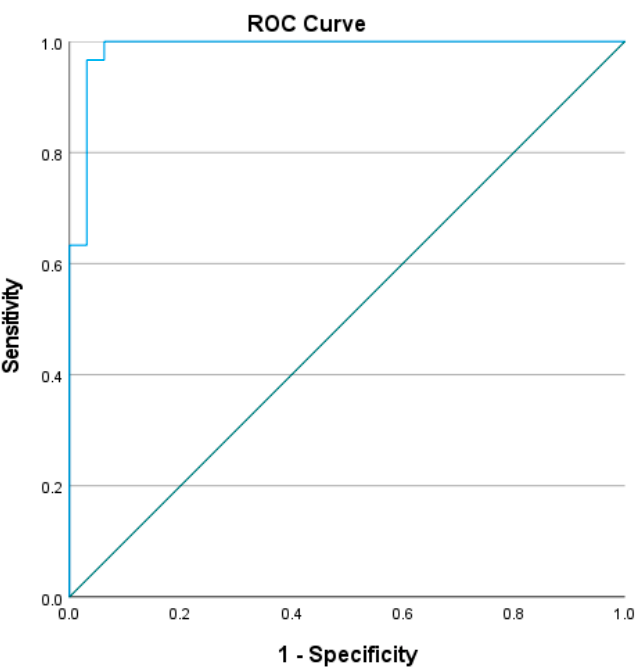
Figure 4. ROC curve of the L Test completion times involving turning towards the non-paretic side for the 90° and then turning towards the paretic side for the 180° (AUC = 98.7%, sensitivity = 96.7%, specificity = 96.9%, p < 0.001).